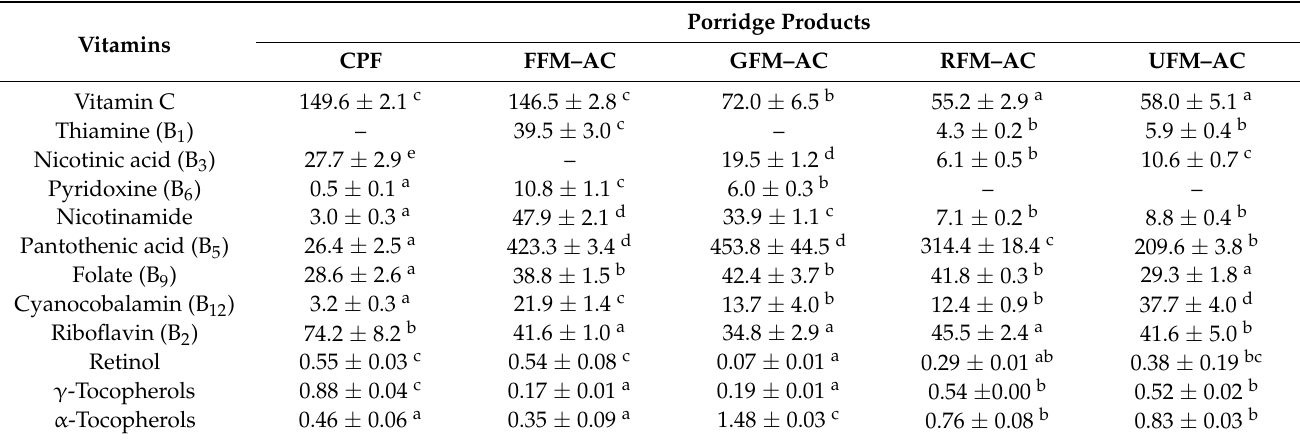
Table 3. Vitamin content (mg/100 g) in porridge flour